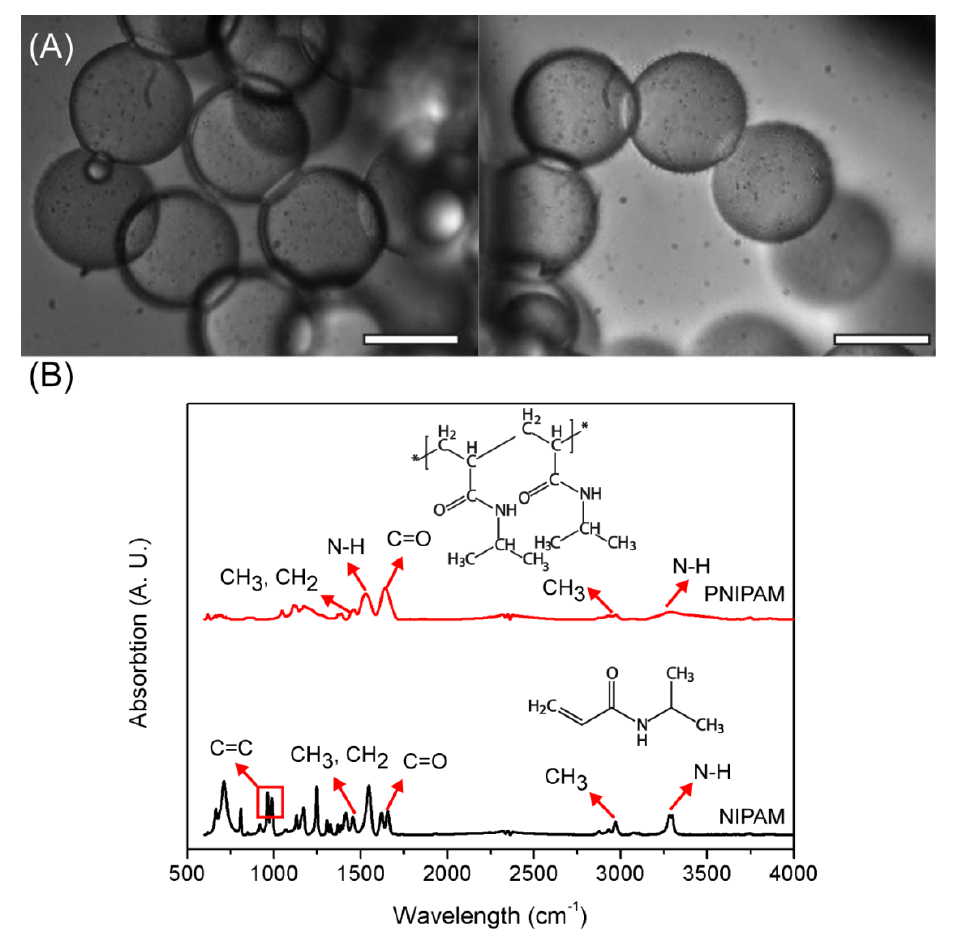
50 μ m; ( B ) FT-IR spectra of NIPAM and